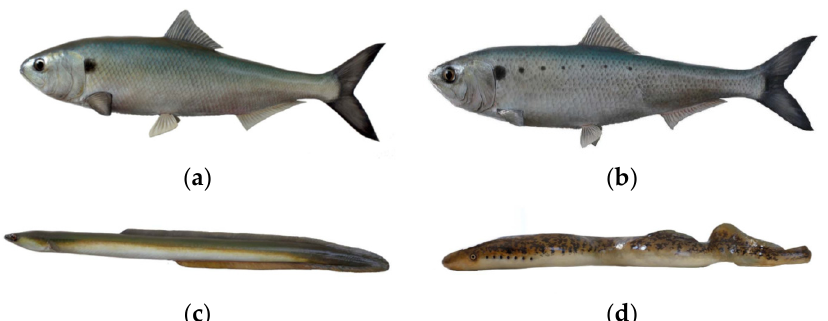
Figure 4. Allis shad ( a ), yellowtail ( b ), European eel ( c ) and lamprey ( d ) (model authors: Pedro Andrade, Cláudia Baeta and Lúcia Antunes, retrieved from [35]).